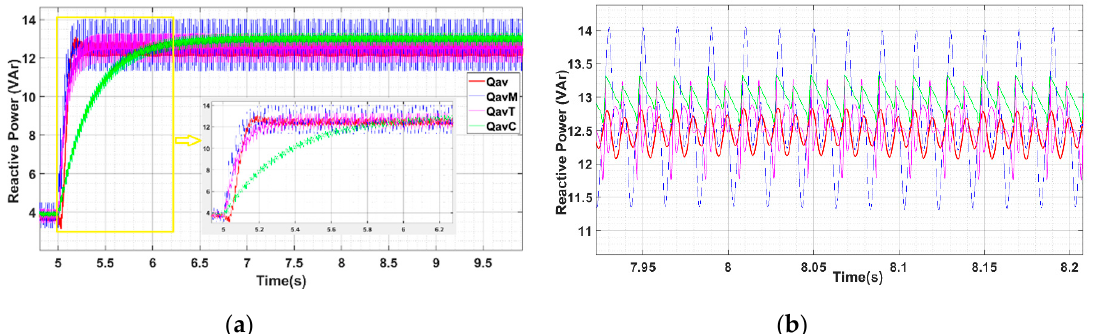
Figure 11. Reactive power plots for Qav (red), QavM (blue), QavT (magenta), and QavC (green): ( a ) transient response detail and ( b ) steady-state ripple detail after load step.